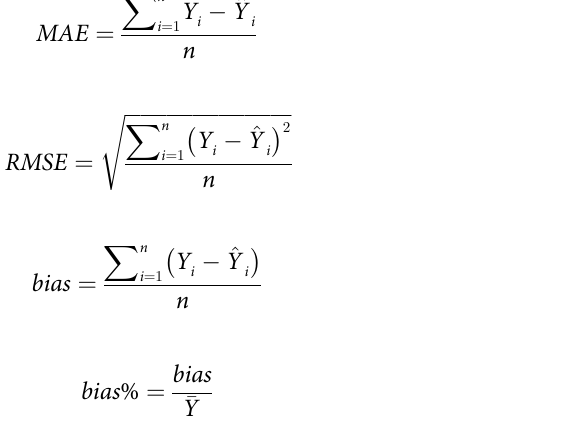
with only intercepts for each proportion level. All models created for each dataset were arranged in order of increasing number of parameters and were compared using analysis of variance (ANOVA), which when used in the DirichletReg package implements a likelihood ratio test to perform pairwise tests of Dirichlet regression models. Models were iteratively removed through ANOVA until a final model for each dataset was selected. These three final models were evaluated by four statistics using leave-one-out cross validation (LOOCV): mean absolute error (MAE), root mean squared error (RMSE), mean bias, and mean relative bias (bias%) using Eqs (3–6).